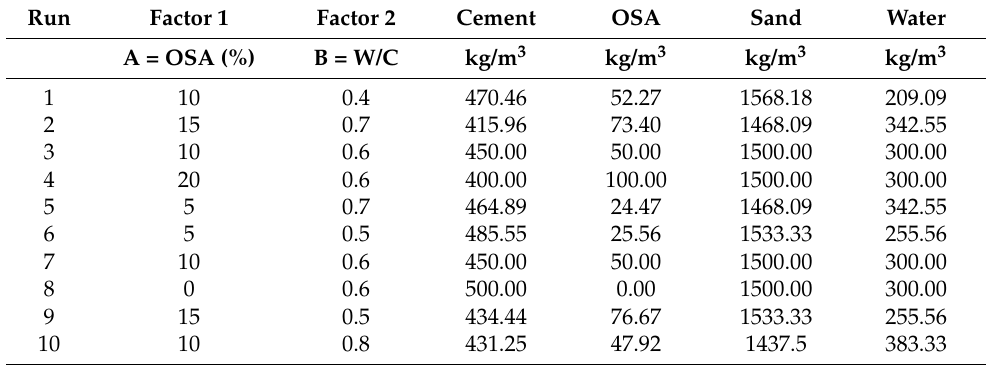
Table 3. Mix formulations of